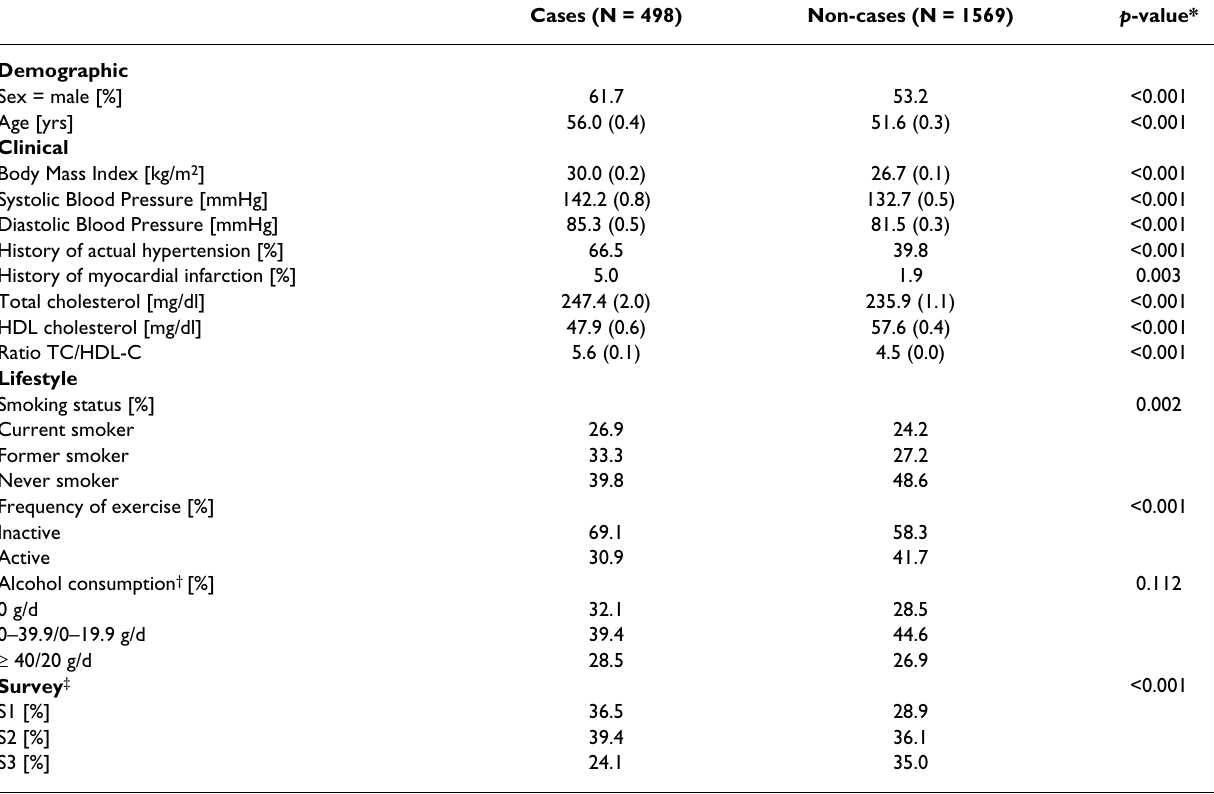
Table 1: Baseline demographic, lifestyle and clinical characteristics of the study participants during follow-up (n = 2,067). Data are weighted percentages for categorical variables and weighted means (standard errors) for normally distributed continuous variables. Cases (N =